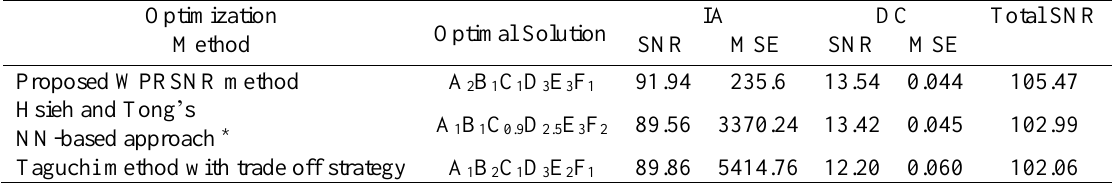
Table 8. Expected MSE and total SNR values under the optimal solution obtained by the